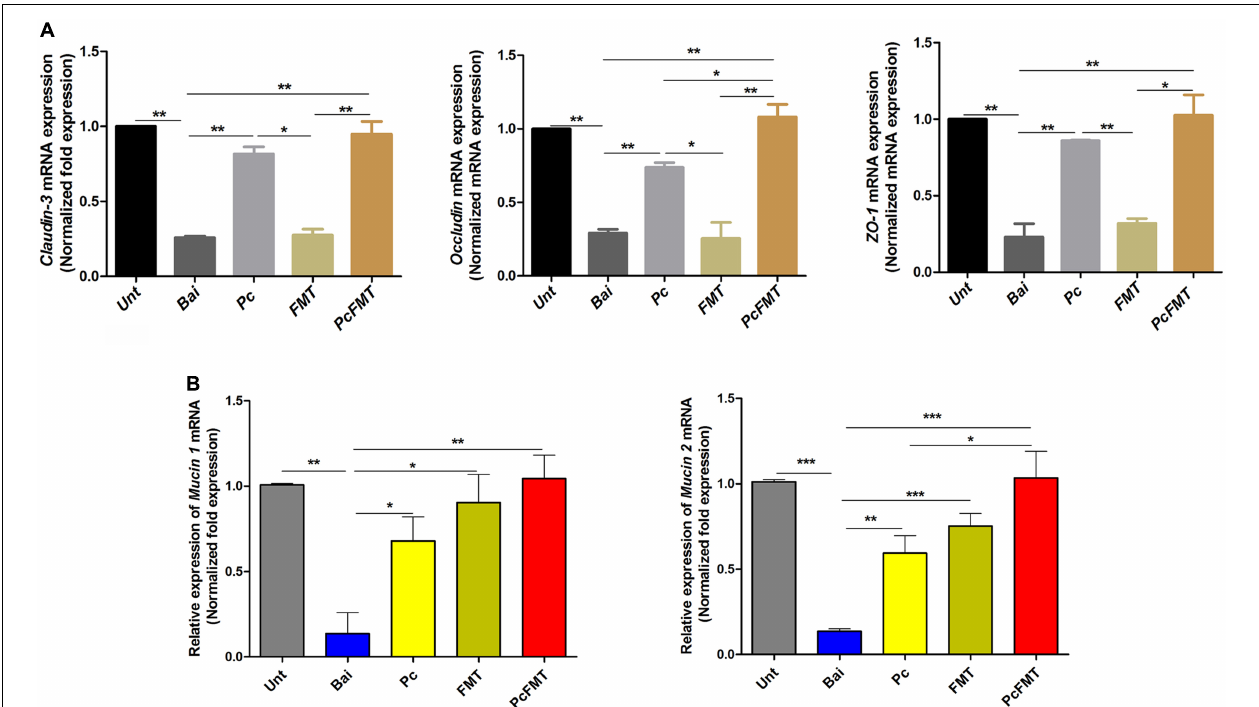
FIGURE 5 | Therapeutic effect of PcFMT on mouse colitis caused by S. Typhimurium. The colonic tissues were collected from healthy, bacterial-infected, single-dose Pc-treated, FMT-treated, and PcFMT-treated mice 48 h after S. Typhimurium (0.2 mL, 4 × 10 8 CFU/mouse) infection. “Unt” represents untreated healthy mice group; “Bai” represents the bacterial-infected mice group; “Pc” means phage cocktail-treated mice group; “PcFMT” represents the combined phage cocktail and FMT mice group. (A) The transcription levels of the tight junction proteins Occludin , Claudin- 3 and ZO -1. (B) The transcription levels of epithelial mucus Mucin 1 and Mucin 2 in colonic tissues. Data are the means ± SEM, n = 6. * P < 0.05; ** P < 0.01; *** P < 0.001 indicate a significant